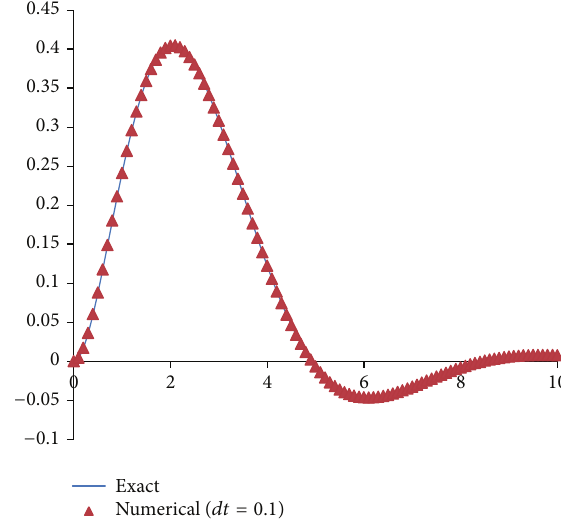
Figure 1: Comparison between the exact and the numerical solu- tions at Δ𝑡 = 0.1 .